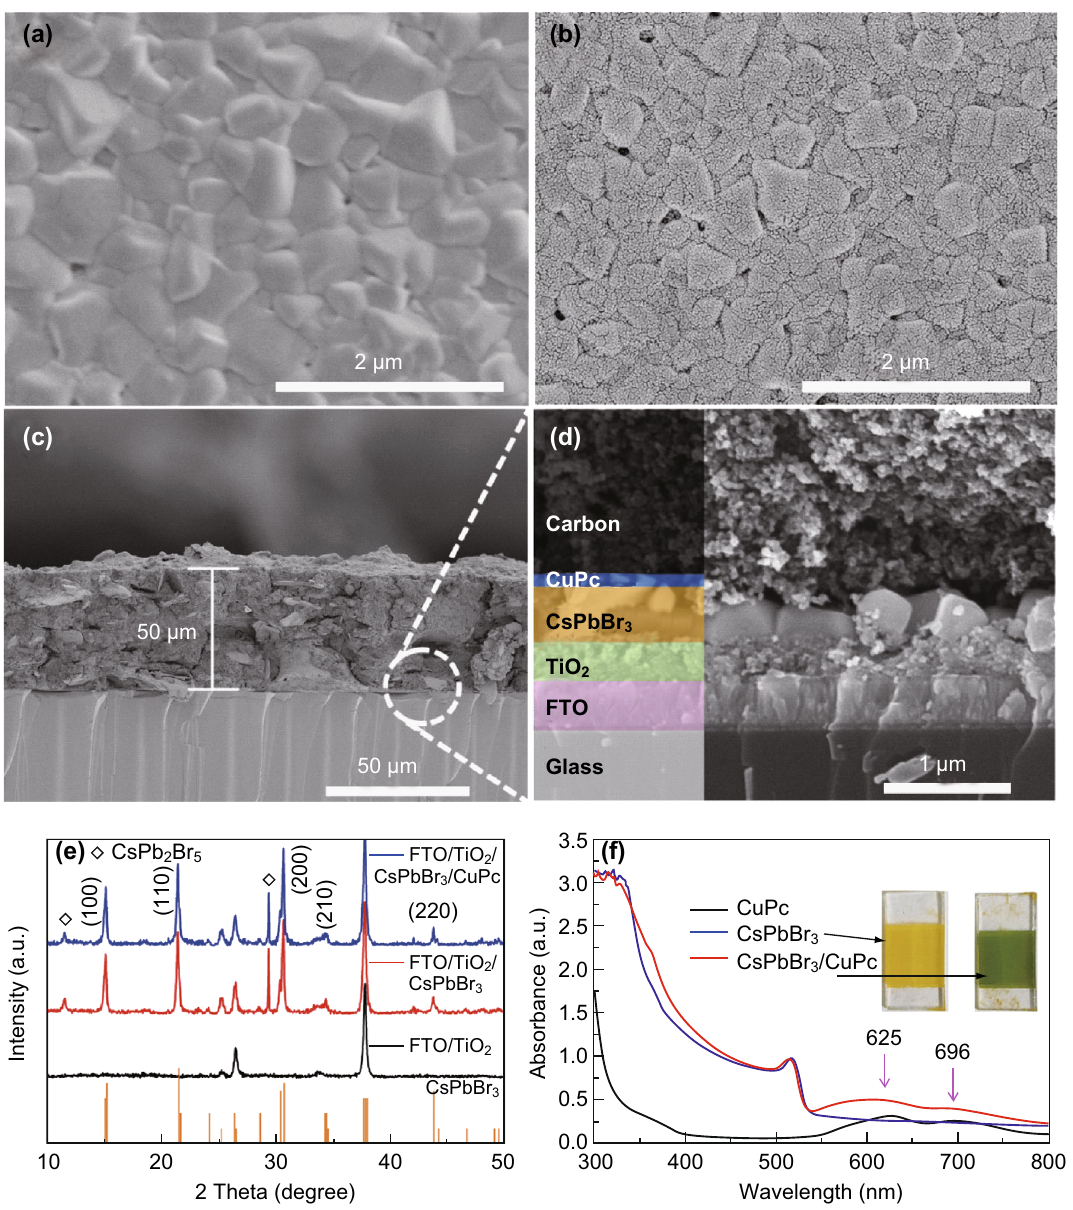
Fig. 2 SEM images of a top view of the CsPbBr 3 perovskite film and b top view of the CsPbBr 3 perovskite film deposited with CuPc. c Cross- sectional SEM image of the whole device. d Close-up of the structure under higher magnification. e XRD spectra of the FTO/TiO 2 , FTO/TiO 2 / CsPbBr 3 , and FTO/TiO 2 /CsPbBr 3 /CuPc. f UV–Vis absorbance spectra of the CuPc, FTO/TiO 2 /CsPbBr 3 , and FTO/TiO 2 /CsPbBr 3